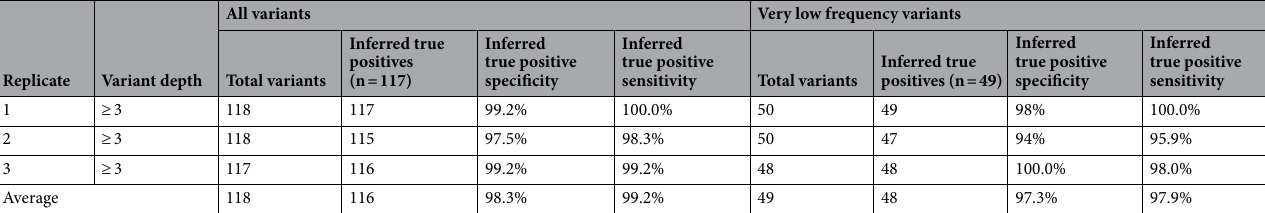
Table 2. Sensitivity and specificity of ATOM-Seq SNV protocol on reference samples using 5 ng of starting material.